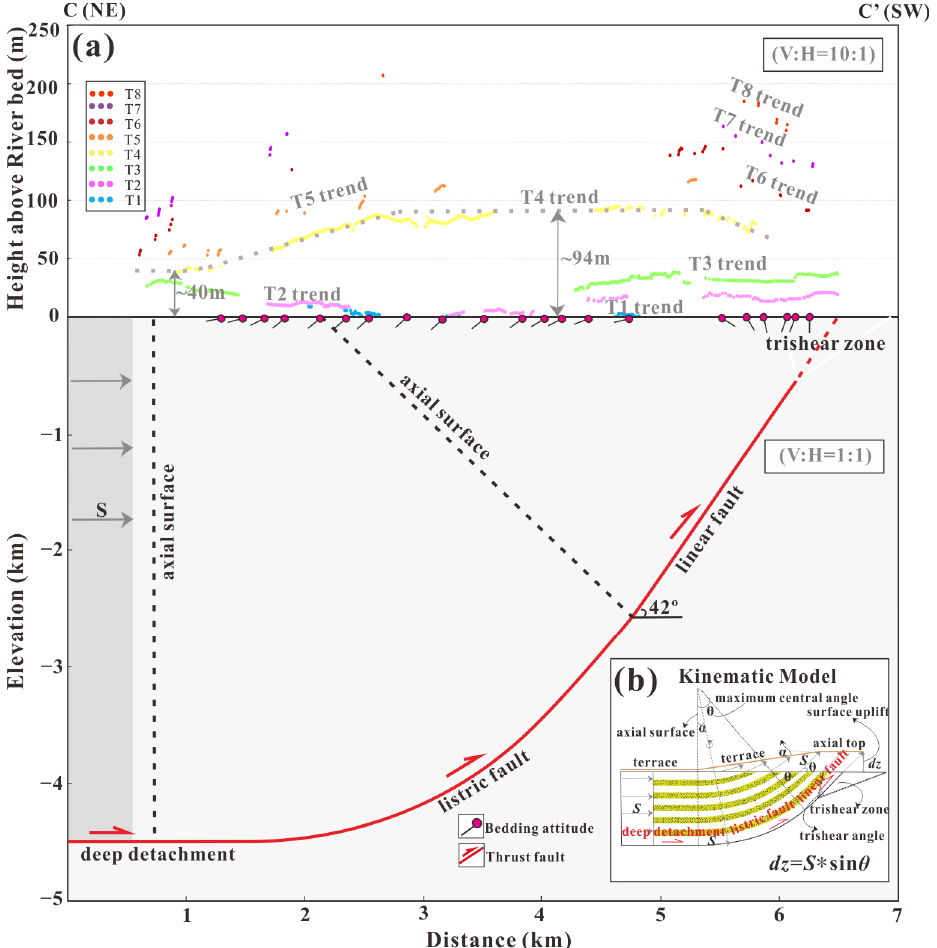
Figure 7. ( a ) Longitudinal profiles of terraces T1–T8 and river channel across the Shengjingou Val- ley. ( b ) Topographic profiles of terraces T1–T8 that removed the modern river gradient. The distance is projected along the line C–C ′ (location see Figure 5c), where C is the direction upstream. In both profiles, the vertical exaggeration is 10.